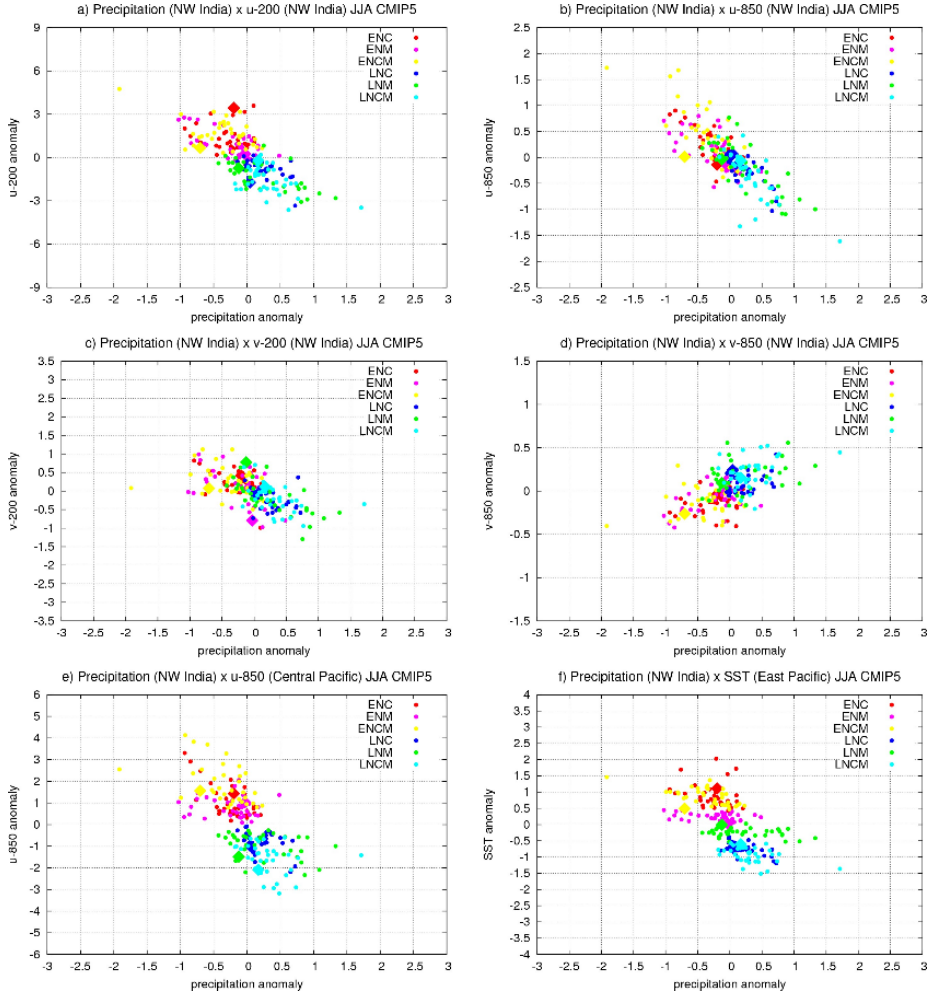
Figure 5. NW Region: ISM precipitation (mm/day) vs. various fields. Precipitation vs. local atmospheric influence of wind (m/s) is shown for U200 ( a ), U850 ( b ), V200 ( c ) and V850 ( d ). Precipitation vs. remote influence from Central Tropical Pacific U 850 ( e ) and East Tropical Pacific SST (°C) ( f ) are also shown.